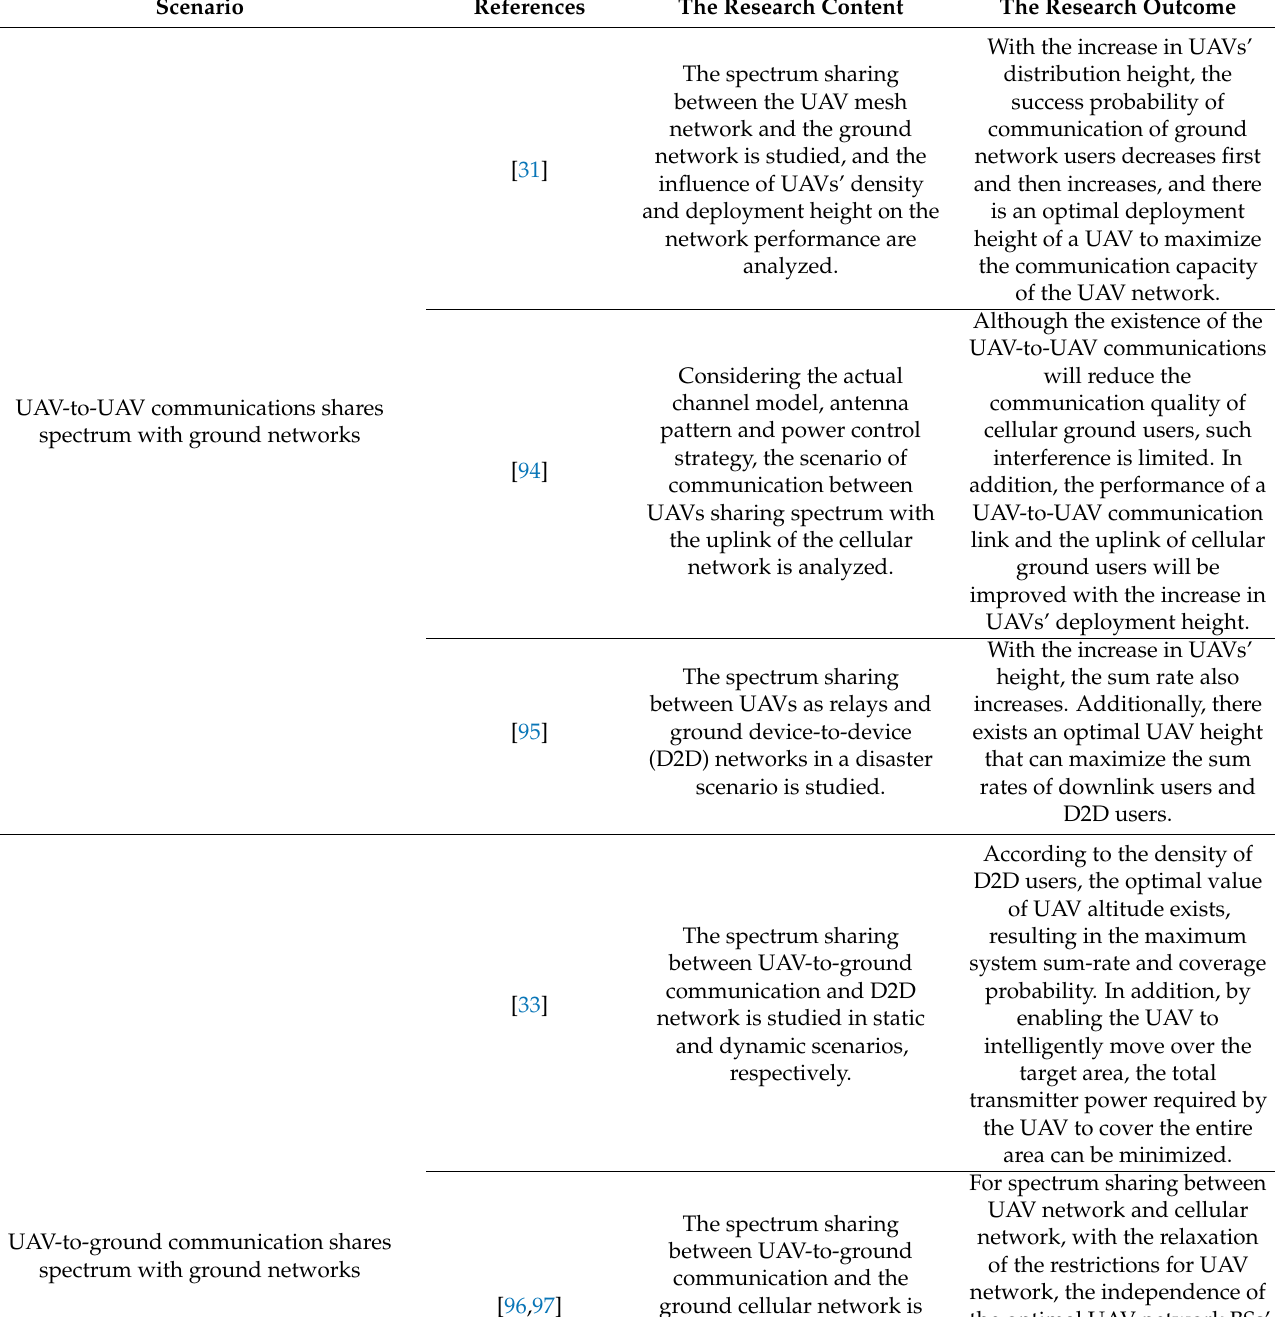
Table 9. Reference related to performance analysis of spectrum